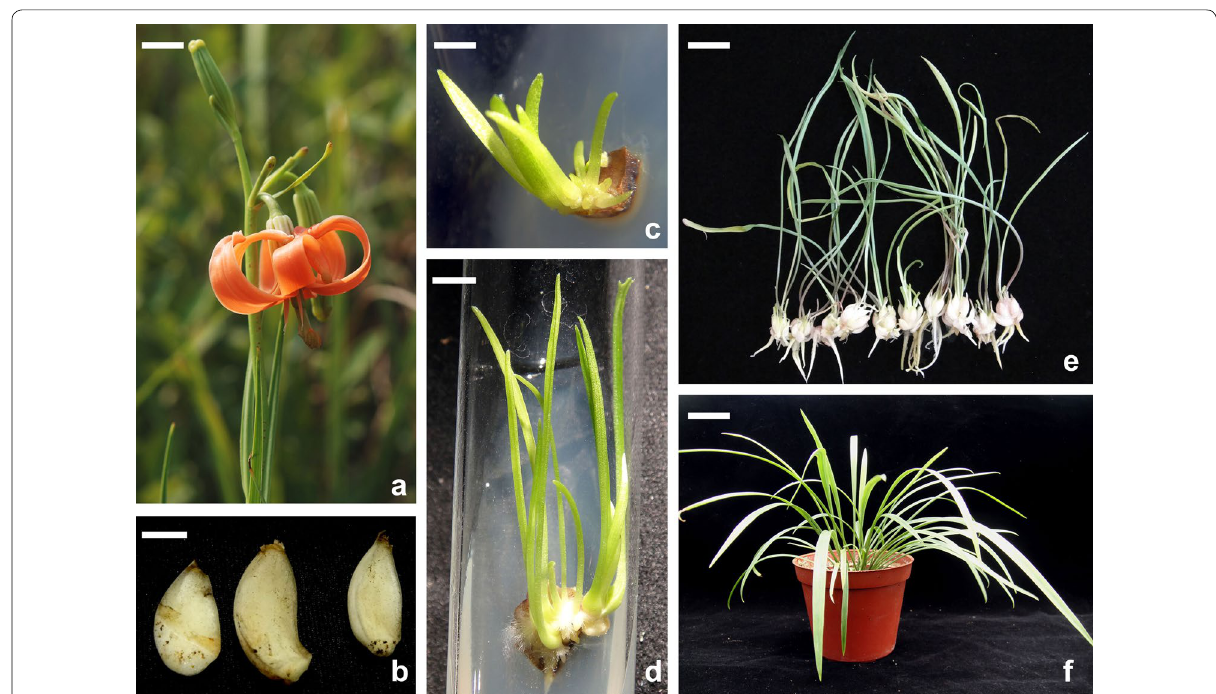
1.6 cm). b Scales collected from wild plants served as explants for in vitro culture. (Bar 0.7 cm). = = 0.3 cm). d Leaf growth and rooting of bulblets. (Bar 0.5 cm). e Well-grown = = 1.5 cm). f Transplanted plants were set in a net house and grew =